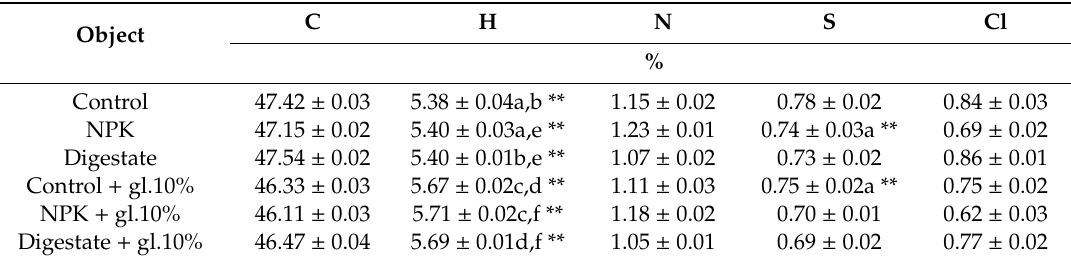
Table 4. Elemental dry mass composition of